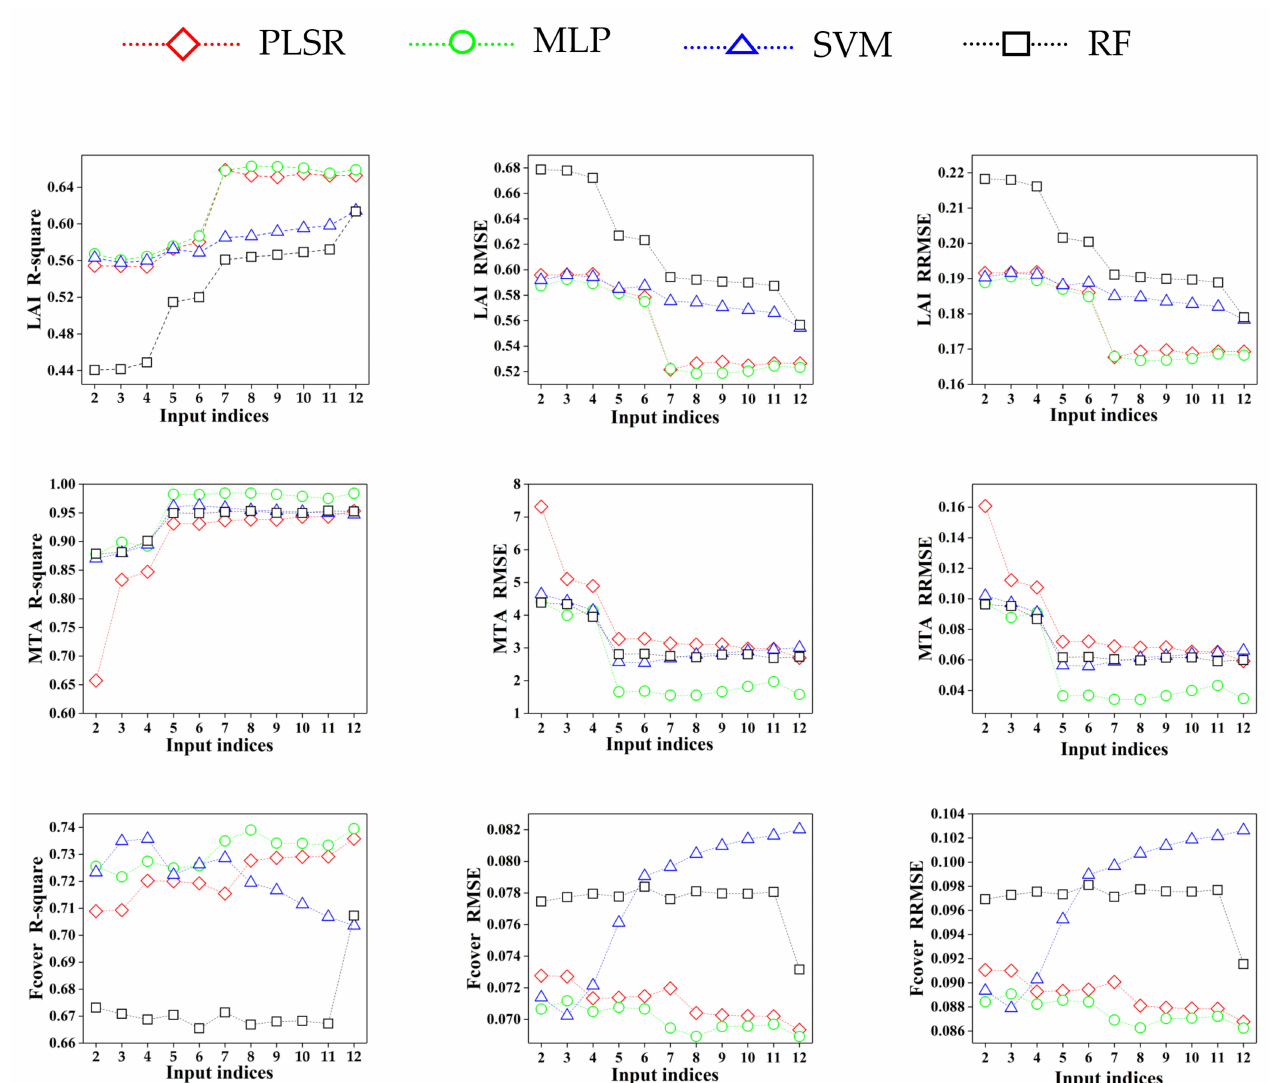
Figure 6. Effects of input vegetation indices on themodel accuracy in field-measured